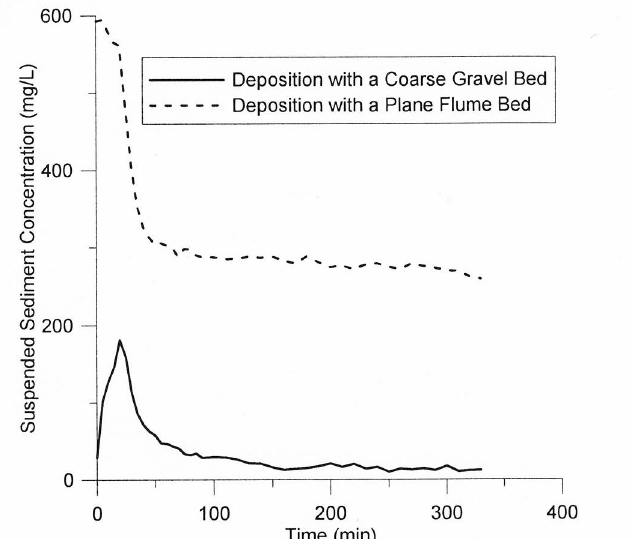
Fig. 3 Sediment deposition with and without gravel at the same flume